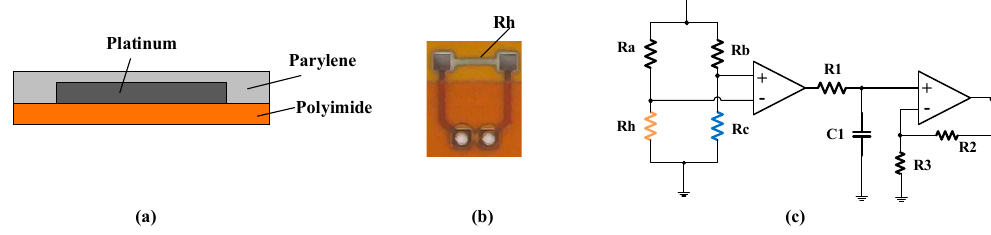
Figure 2. ( a ) Configuration of hot-film sensor; ( b ) Sensor prototype; ( c ) CTD circuit.